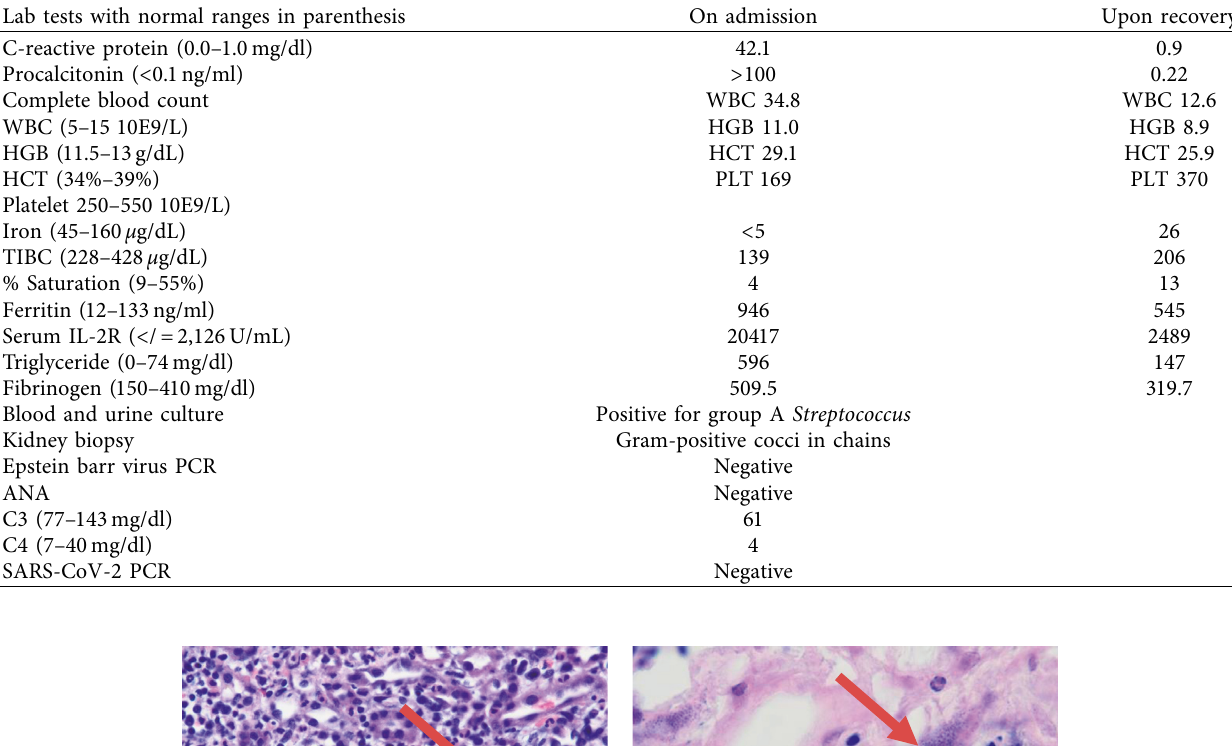
Table 1: Lab work at admission and upon